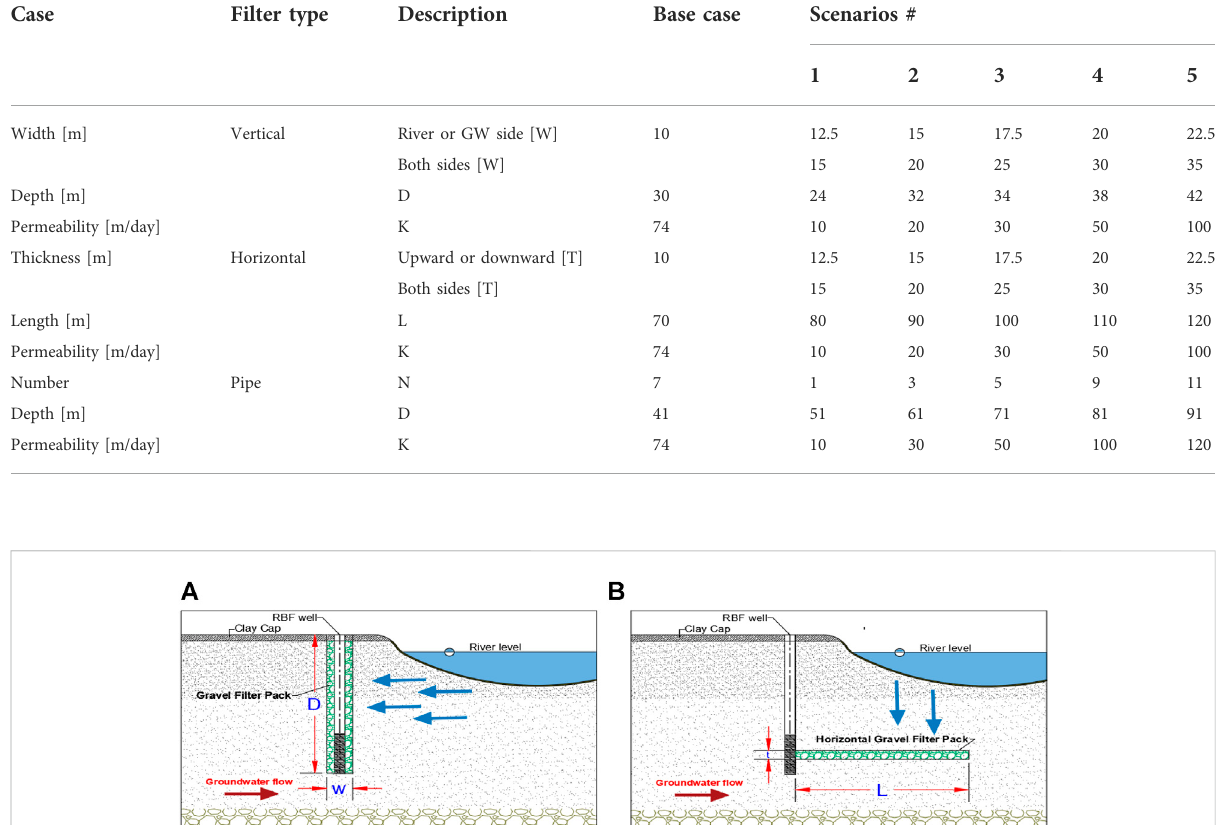
TABLE 2 Different proposed scenarios for fi lter emplacement.